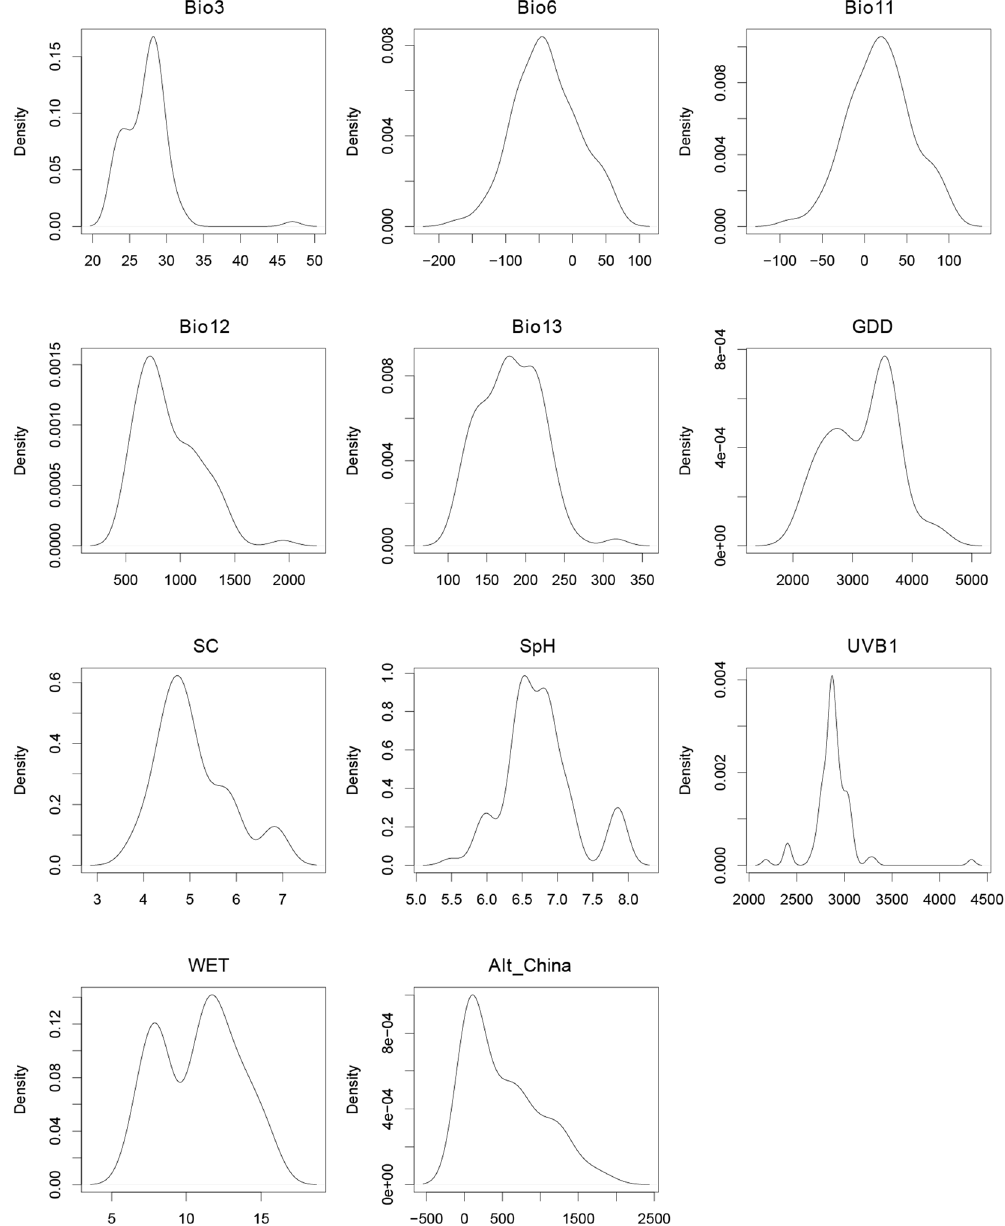
Figure 2. Response curves for important environmental variables in the species distribution model for P . ostii